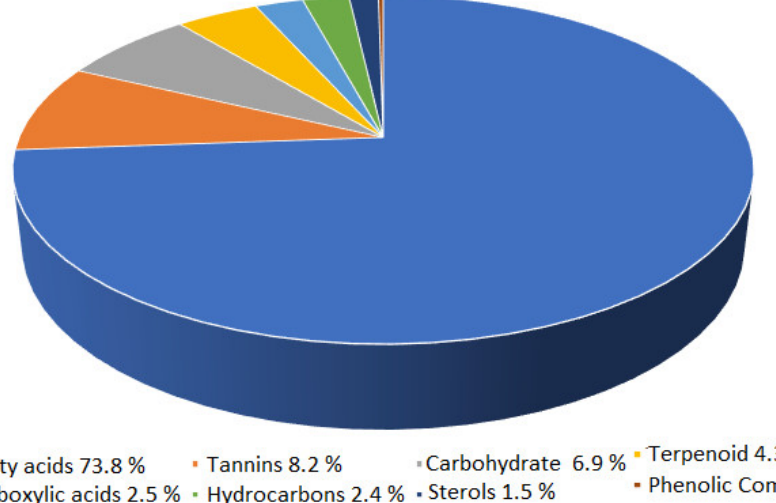
Figure 1. Phytochemicals in water-extracted compounds from Saussurea costus as identified by GC-MS.